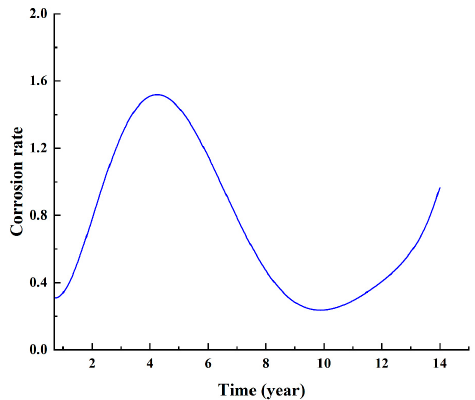
Figure 2. Variation curve of average mass corrosion rate with time.